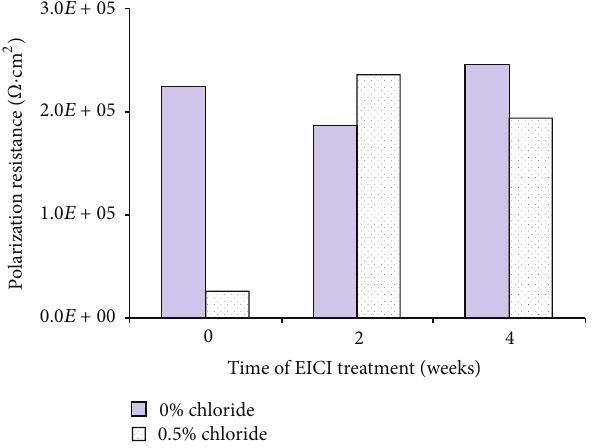
Figure 12: Polarization resistance values of steel rebar embedded in chloride-contaminated cement mortar before and after EICI treatment in sodium borate